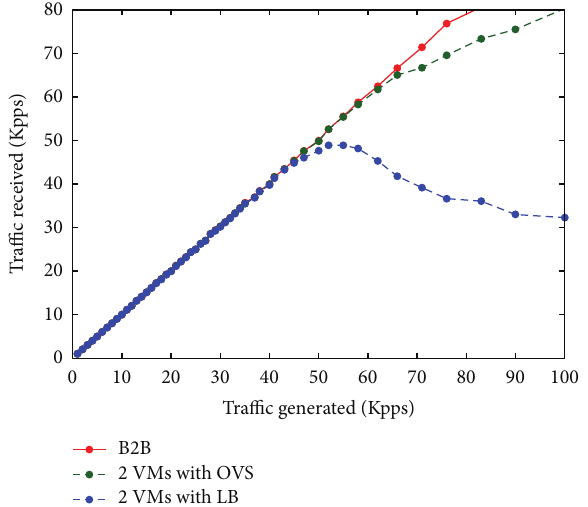
Figure 12: Received versus generated packet rate in the Non- OpenStack scenario setup (2.3), with 1500 -byte packets.